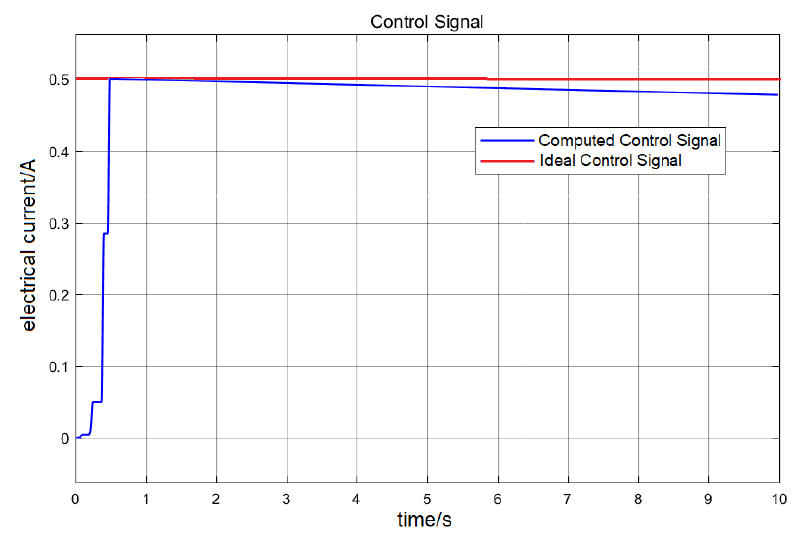
Figure 9. Control signal generated by the BEL